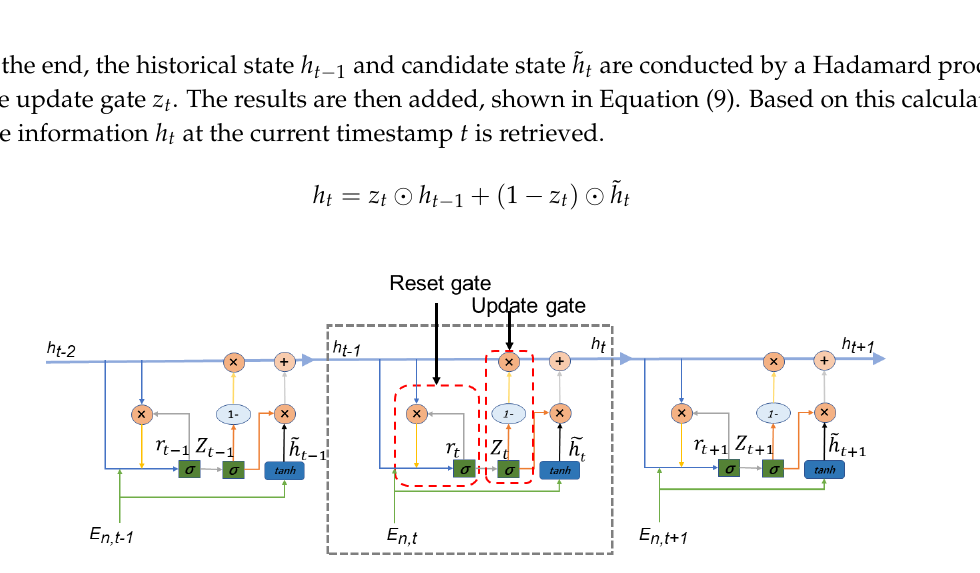
Figure 4. Forward propagation of the GRU